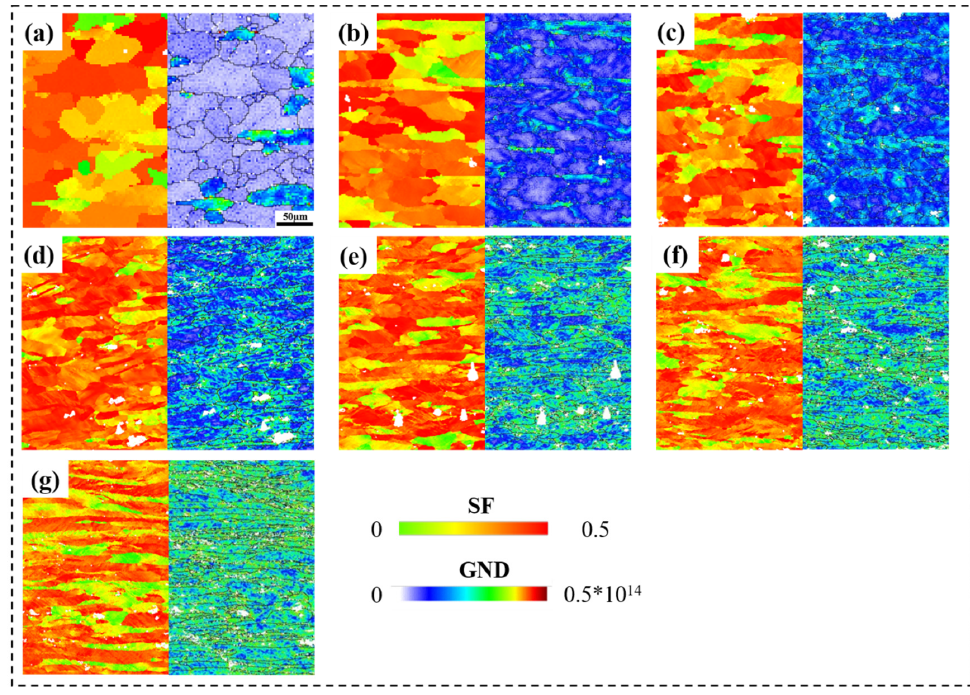
Figure 5. SF and GND maps at different CRF deformation amounts: ( a ) as-annealed, ( b ) 10%, ( c ) 20%, ( d ) 30%, ( e ) 40%, ( f ) 50%, and ( g ) 60%.